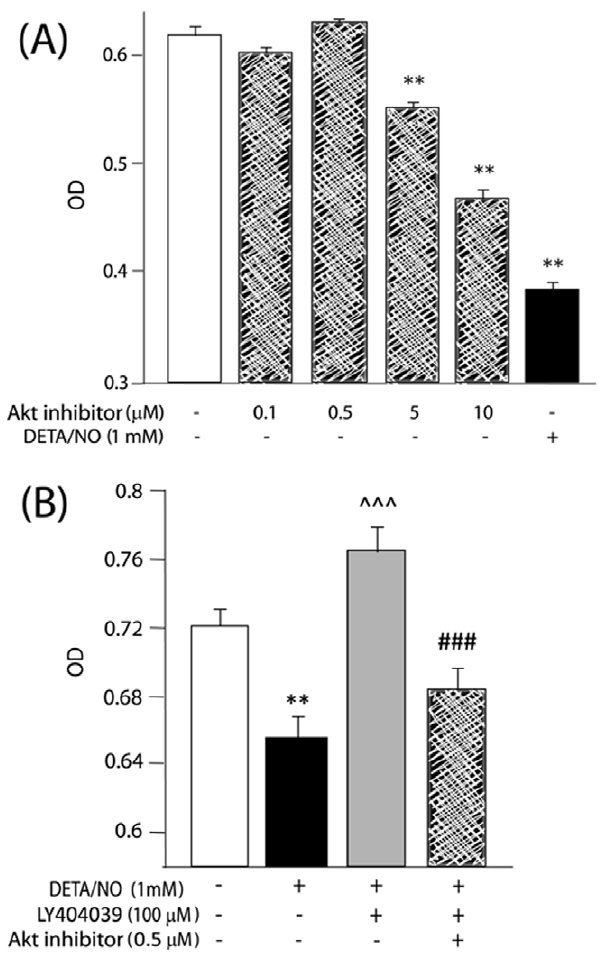
Figure 6. Akt activity mediates the antiapoptotic effect of mGluR3 agonists in astrocytes. (A) A dose-response curve was plotted by a MTT assay to determine the optimal concentration of the Akt inhibitor. (B) Astrocytes were treated with 1 mM DETA/NO in the presence or absence of 100 m M LY404039 and/or Akt inhibitor (0.5 m M) for 48 h. Cell viability was assayed by the MTT method. Bars represent the mean 6 SEM of 6–8 determinations per group of one representative experiment of 2 independent ones. **p , 0.01 versus control; ‘‘‘ p , 0.001 versus DETA/NO; ### p , 0.001 versus DETA/ NO + LY404039.